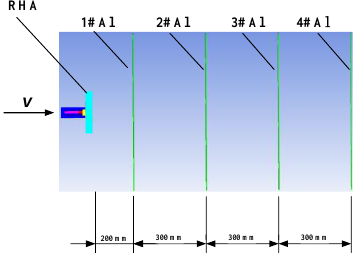
Figure 2. Schematic diagram of the RMP.